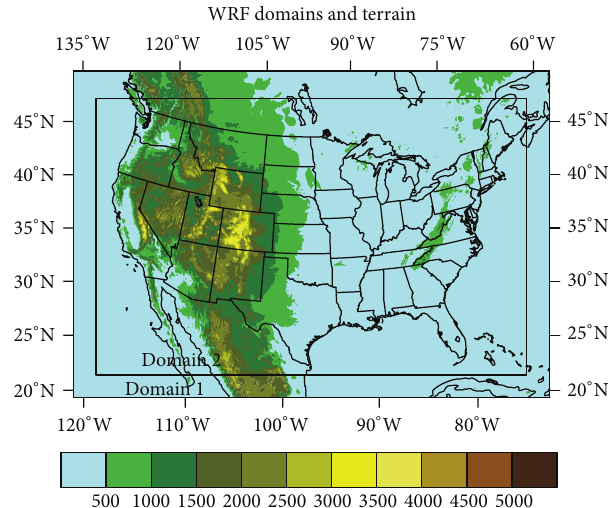
Figure 1: WRF-RTFDDA model domains with one nest (Domain 1: 12km; Domain 2: 4km). Shades represent terrain height (m) for the corresponding WRF